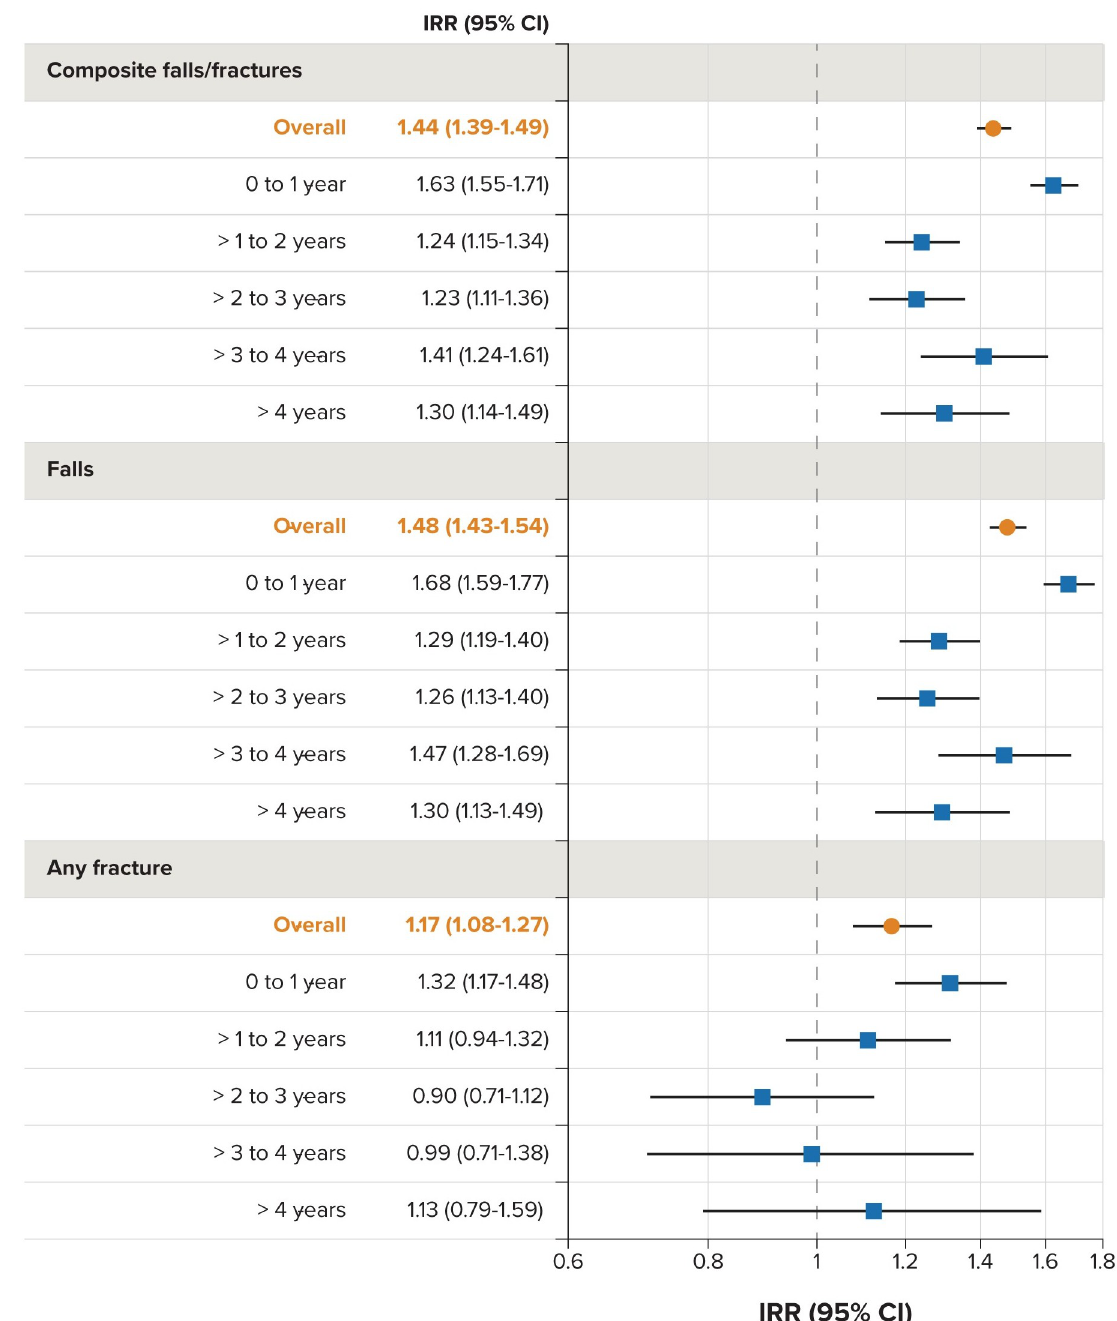
Fig 2. Incidence rate ratios of falls and fractures for the matched PD-PDP cohort, overall and by time interval. CI = confidence interval; IRR, incidence rate ratio; matched PD-PDP cohort = cohort of patients with PD without PDP matched to patients with PDP; PD = Parkinson disease; PDP = Parkinson disease with